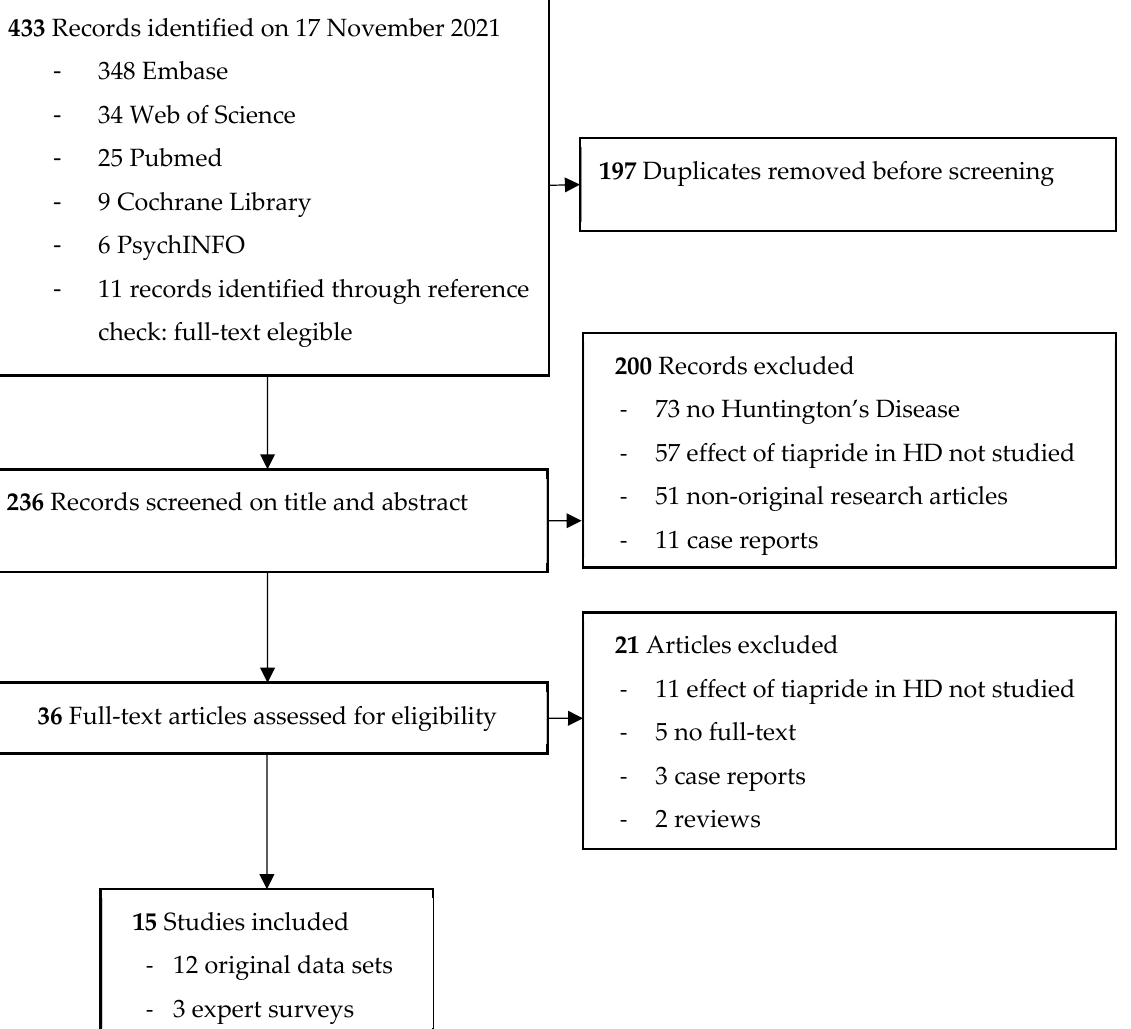
Figure 2. Flow diagram of selected